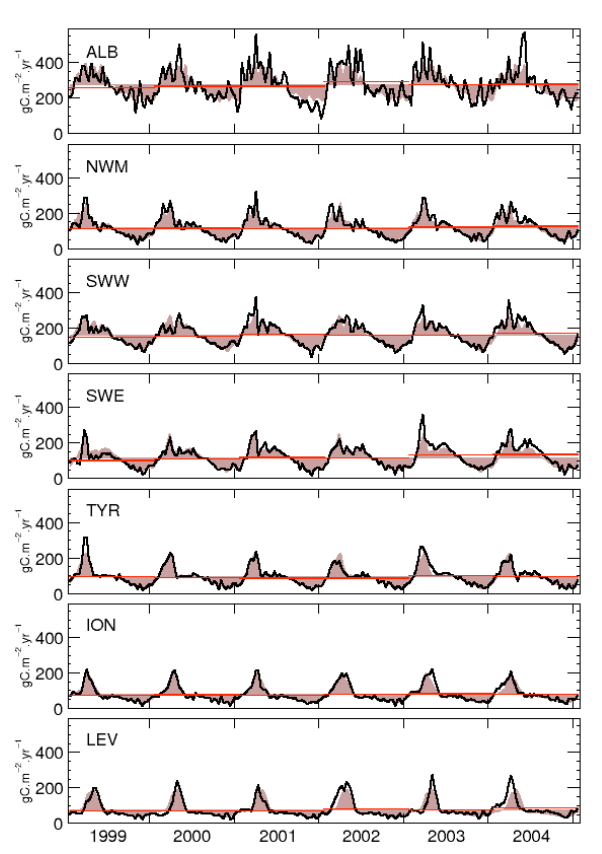
Fig. 9. Temporal series of integrated net primary production (gCm − 2 yr − 1 ) averaged for the 7 areas of Fig. 1 (black line); cli- matological values for the period 1999–2004 (brown shading), and annual averages (red